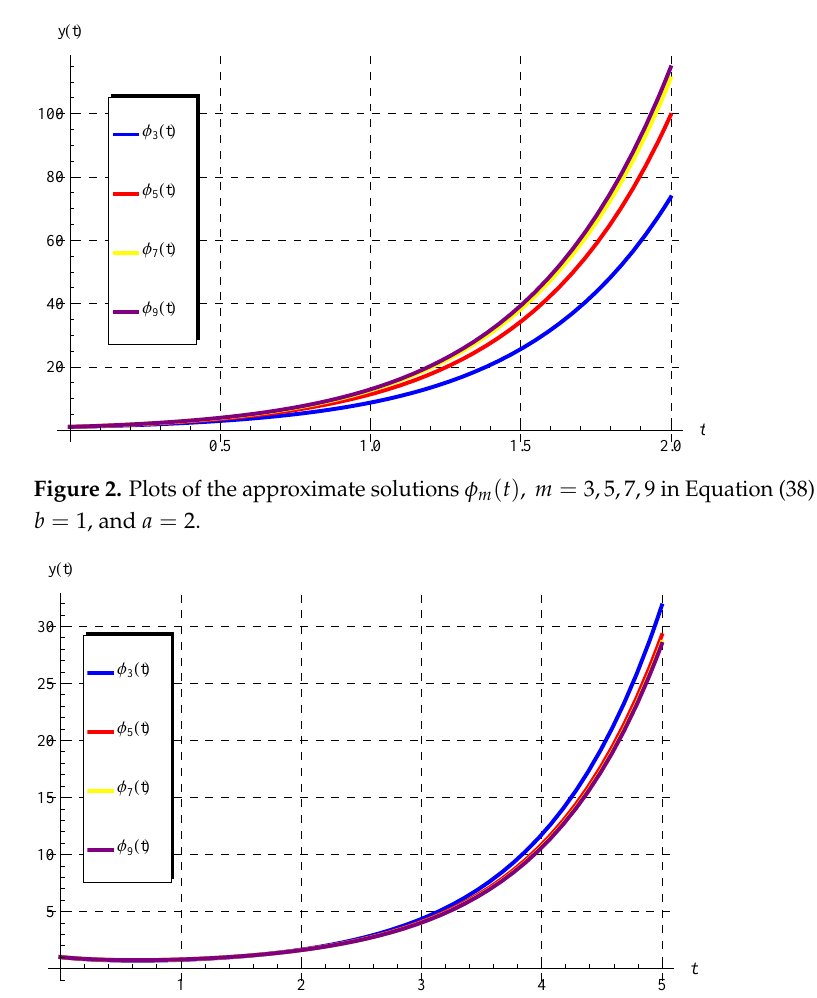
Figure 3. Plots of the approximate solutions φ m ( t ) , m = 3,5,7,9 in Equation (38) vs. t at λ = 1, c = − 1 , b = 1, and a = − 2. 2